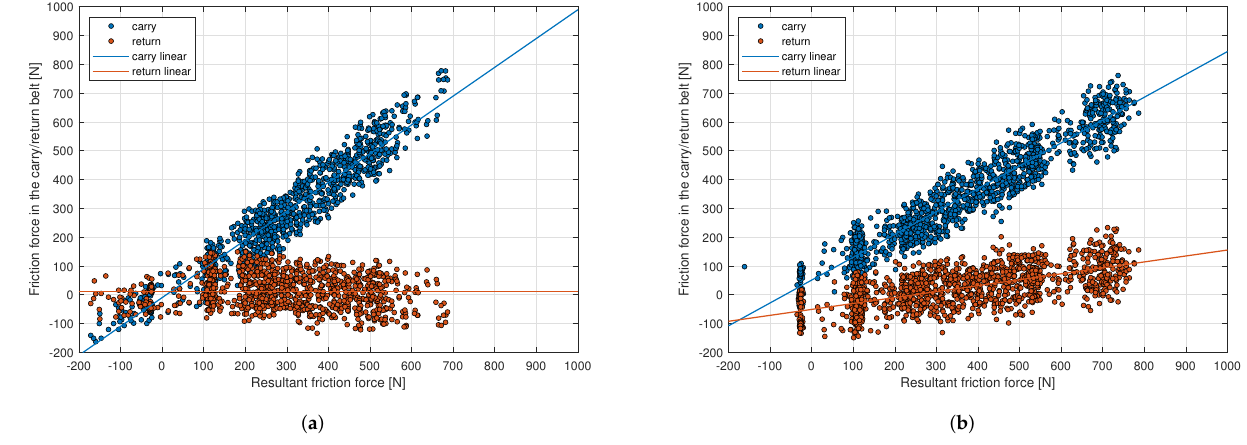
Figure 9. Transmitted friction force: ( a ) for coupling at the carry side, ( b ) for coupling at the carry and return